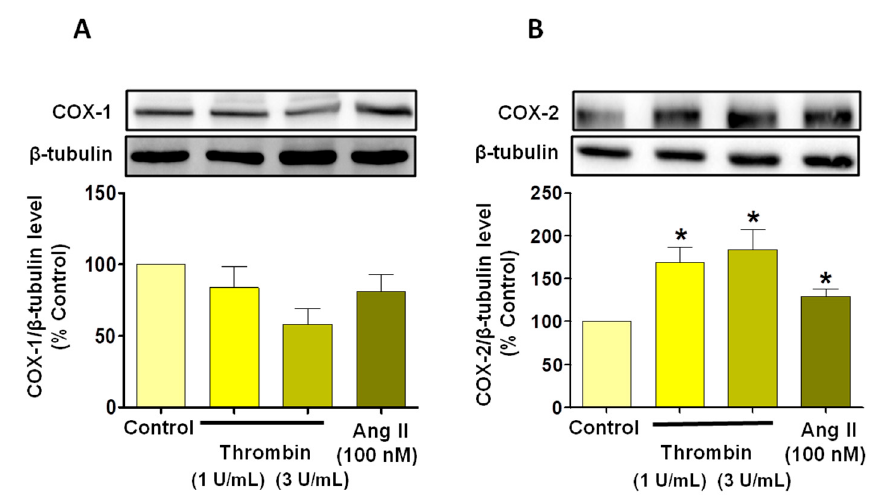
Figure 3. Thrombin and AngII induce the expression of cyclooxygenase-2 in atrial ECs. Atrial ECs were either untreated or exposed to thrombin (1 or 3 U/mL) or AngII (100 nM) before determination of the expression level of ( A ) COX-1 and ( B ) COX-2, as assessed by Western blot analysis. Results are shown as representative immunoblots (upper panels) and corresponding cumulative data (lower panels) and shown as mean ± SEM, n = 3–4, * P < 0.05 versus respective control.